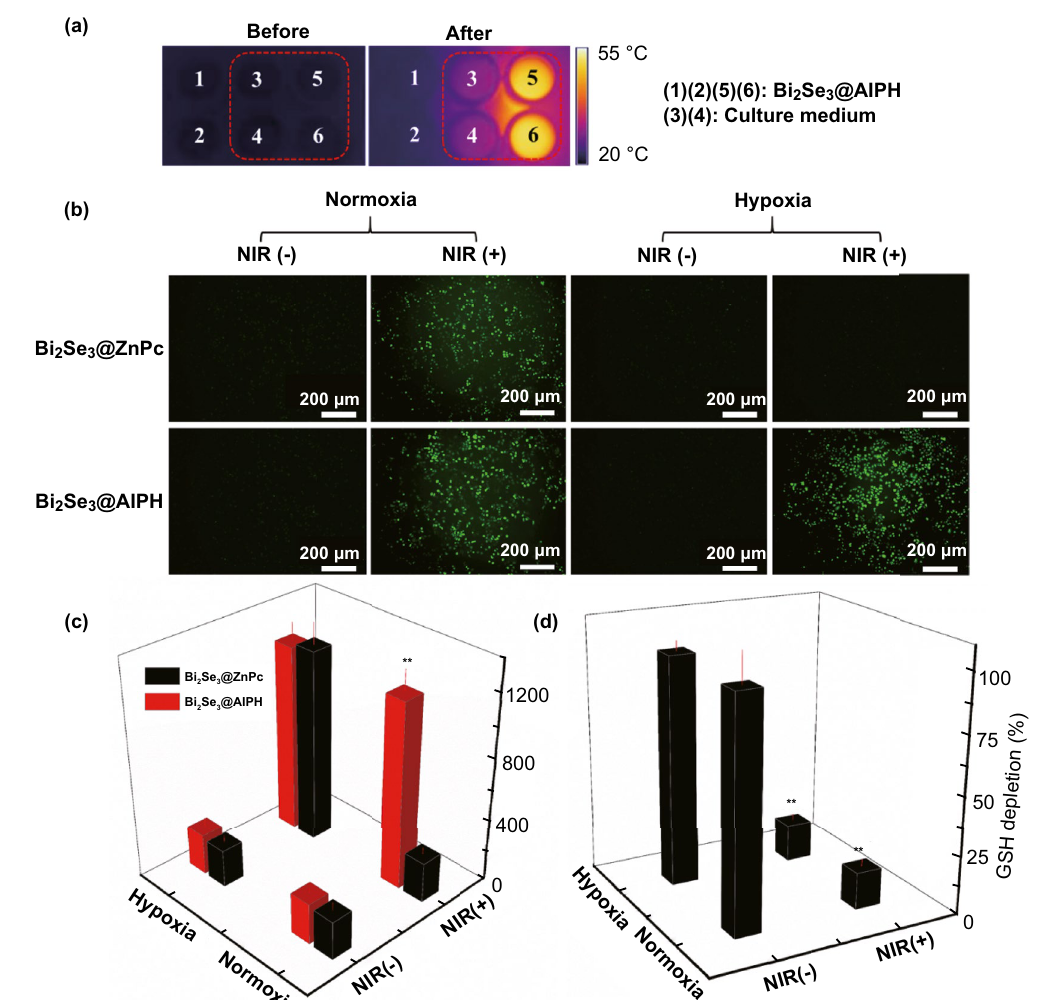
Fig. 2 In vitro photothermal and free radial effect. a Thermal images of HepG2 cell culture medium in 96-well plate: (1), (2), (5), and (6) were added with Bi 2 Se 3 @AIPH NPs, while (3) and (4) were added with culture medium; the area in the red dotted frame was treated with 5 min exposure to 808 nm laser. b Characterization of intracellular free radical and its oxidation products after exposure to 808 nm laser by DCFH-DA assay and c the corresponding quantitative fluorescence intensity. * p < 0.05, ** p < 0.01 compared to the one treated with Bi 2 Se 3 @ZnPc NPs at the same condition. d Percentage of GSH amount in HepG2 cells treated with Bi 2 Se 3 @AIPH NPs (in normoxic and hypoxic atmosphere). * p < 0.05, ** p < 0.01 compared to the one in the control cells. n =